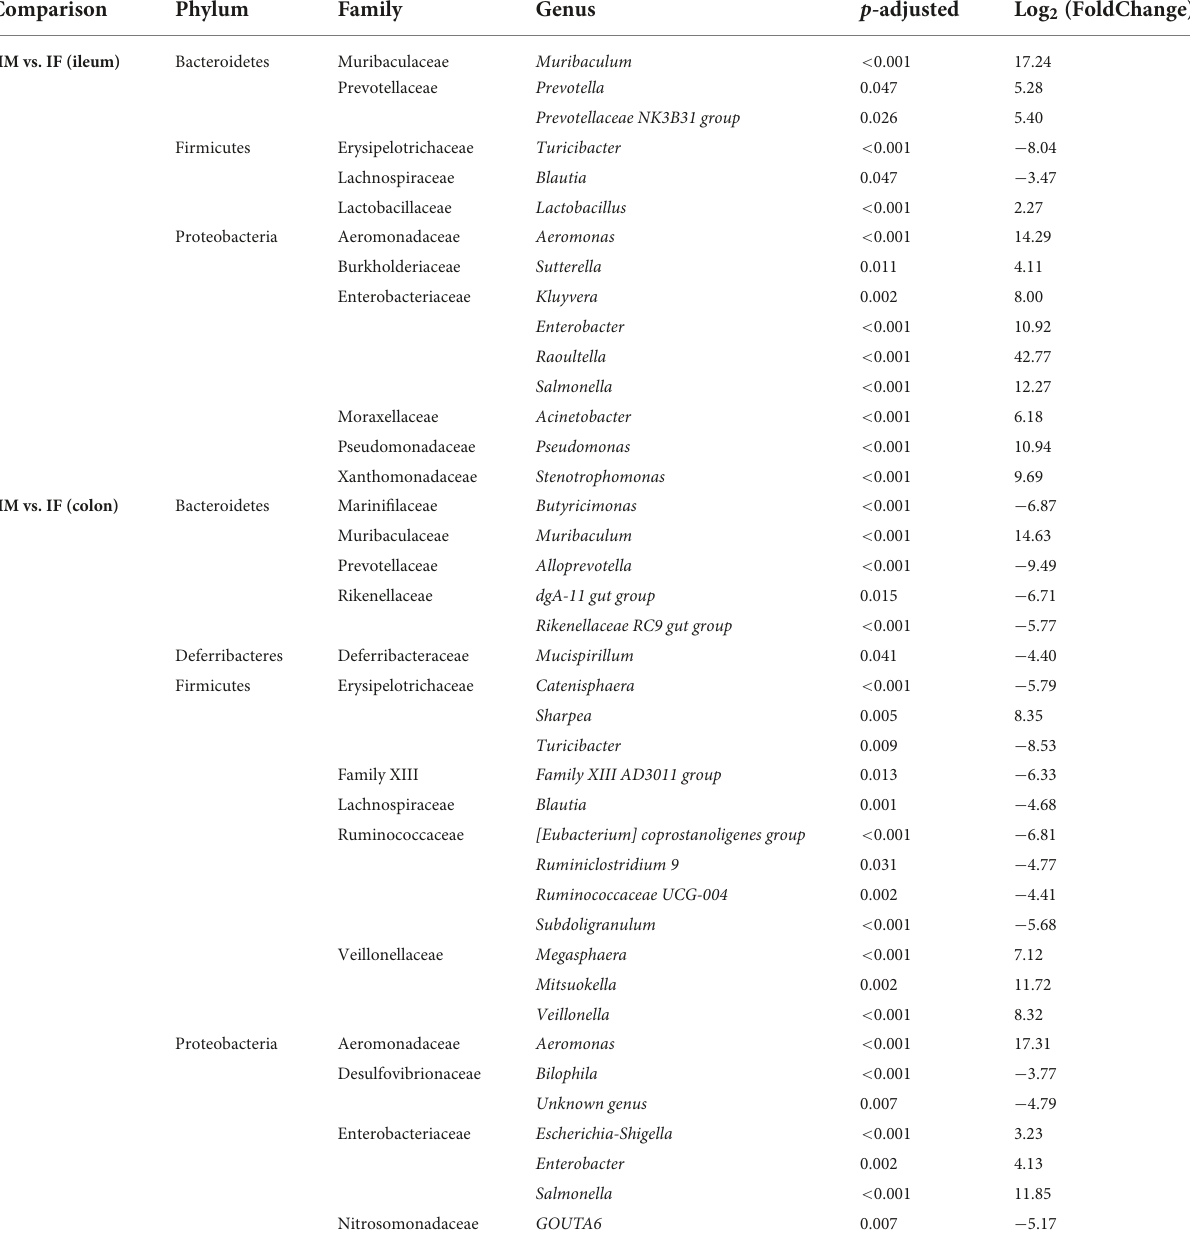
TABLE 3.1 Dietary impact on relative abundance of bacterial genera in the ileum and colon of HM- and IF-fed piglets.